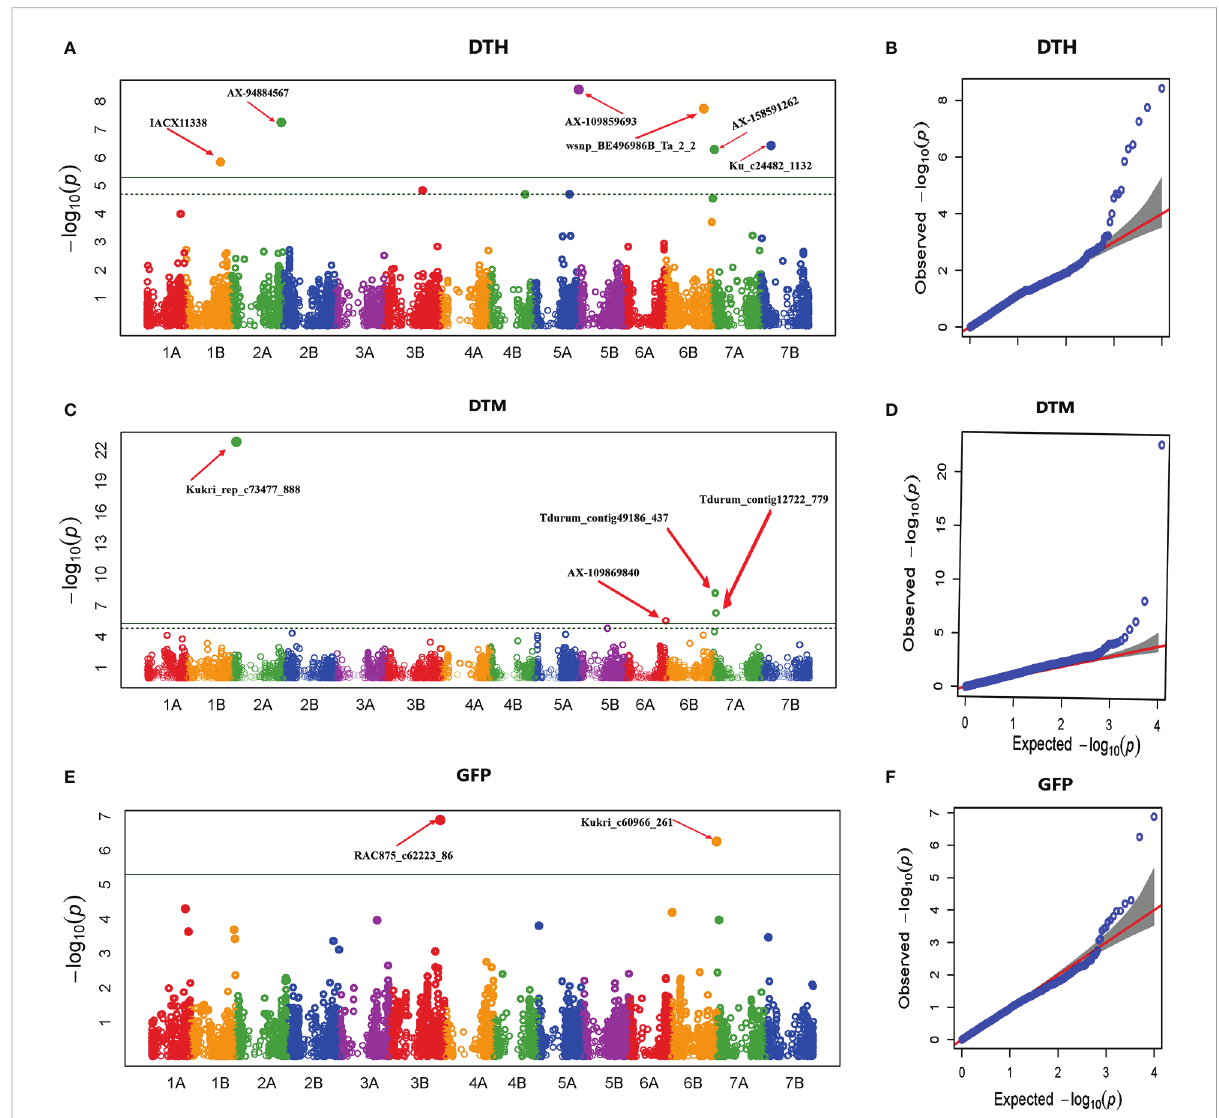
FIGURE 5 Manhattan and Q-Q plots of GWAS scan for phenological traits generated based on combined data from fi ve locations. DTH (A, B) , DTM (C, D) , and GFP (E, F) . For the Manhattan plots, the y-axis represents -log10 (p) of the traits, while the x-axis represents the relative positions of the SNP markers on each chromosome. DTH, Days to heading; DTM, Days to maturity; GFP, Grain- fi lling